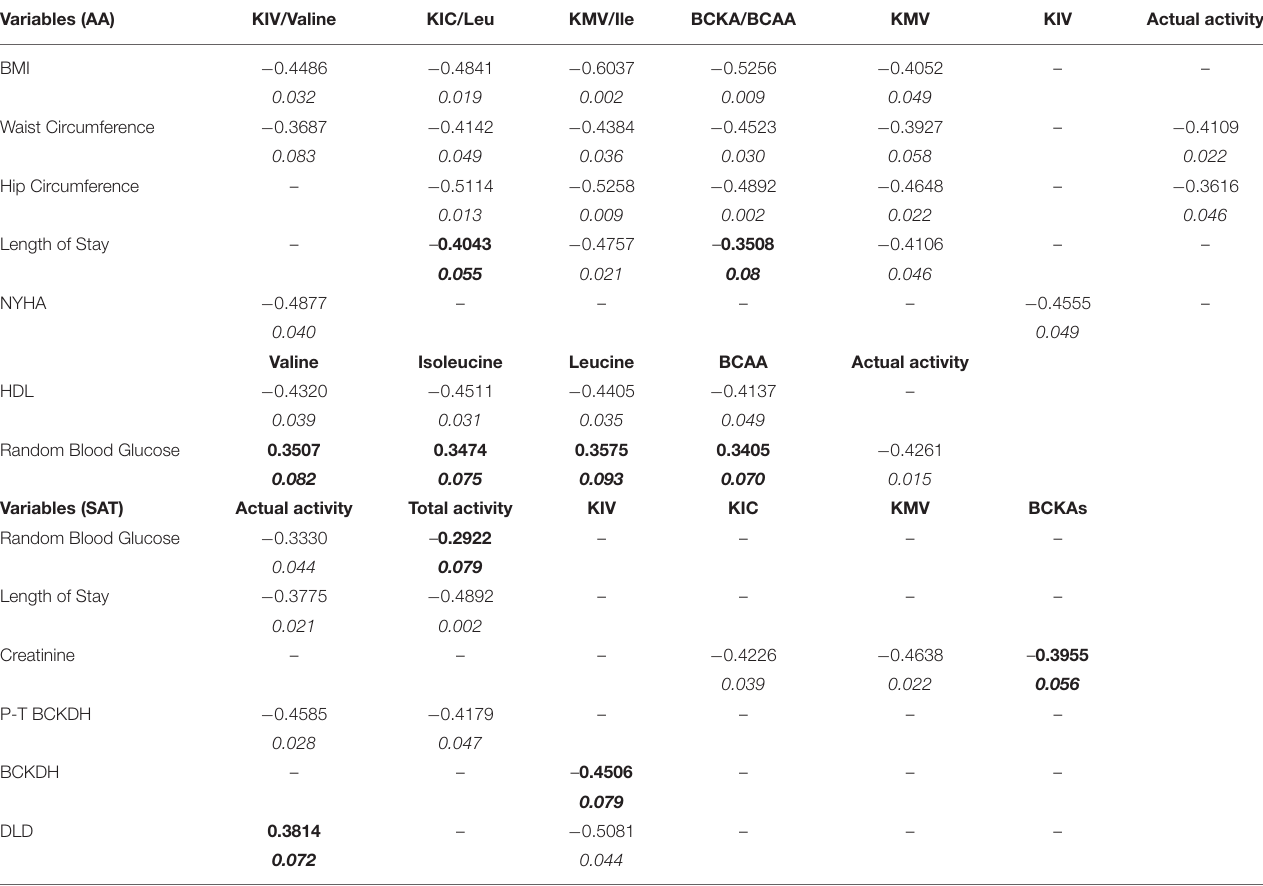
TABLE 6 | Unadjusted Spearman’s correlations ( p < 0.05) for intracellular BCAA and BCKAs content and BCKDH enzyme activity in AA and SAT from cardiac surgery patients. Variables